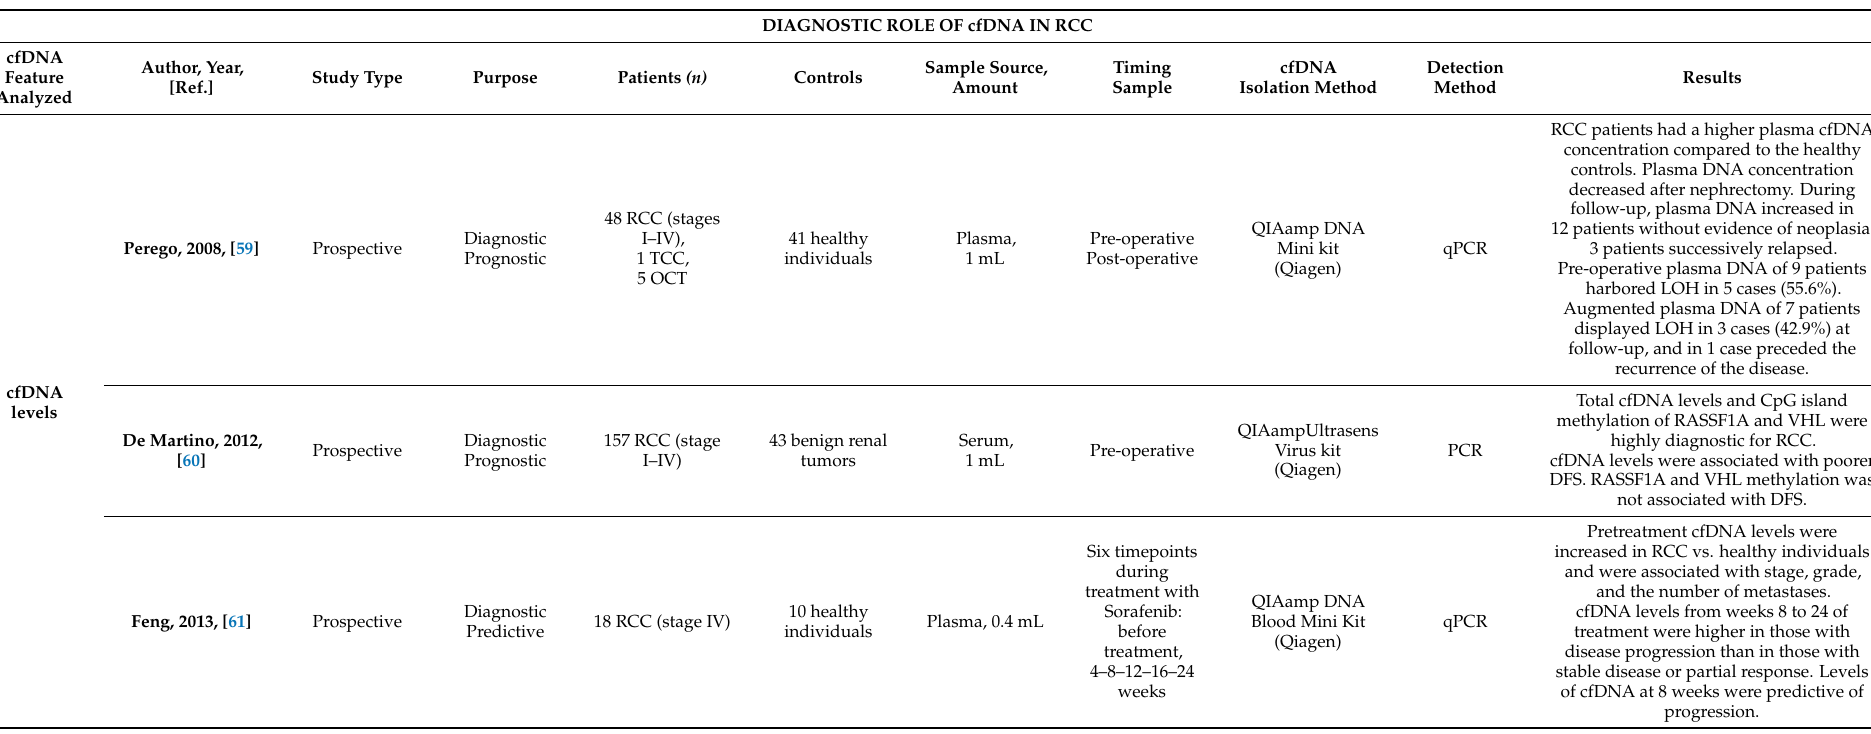
Table 3. Summary of the studies evaluating the diagnostic role of circulating cell-free DNA (cfDNA) in renal cell carcinoma (RCC). AUC: area Under the Curve; p16:cyclin-dependent kinase inhibitor 2A; ACTB: actin beta gene; APC: adenomatosis-polyposis-coli gene; cfDNA: circulating cell-free DNA; CfMEDIP-seq: cell-free methylated DNA immunoprecipitation-sequencing; FHIT: fragile histidine triad gene: GA: genetic alteration; GSTP1: glutathione-S-Transferase Pi 1 gene; LOH: loss of heterozygosity; LRRC3B: leucine rich repeat containing 3B gene; mRCC: metastatic Renal Cell Carcinoma; NF1: neurofibromatosis type 1 gene; OS: